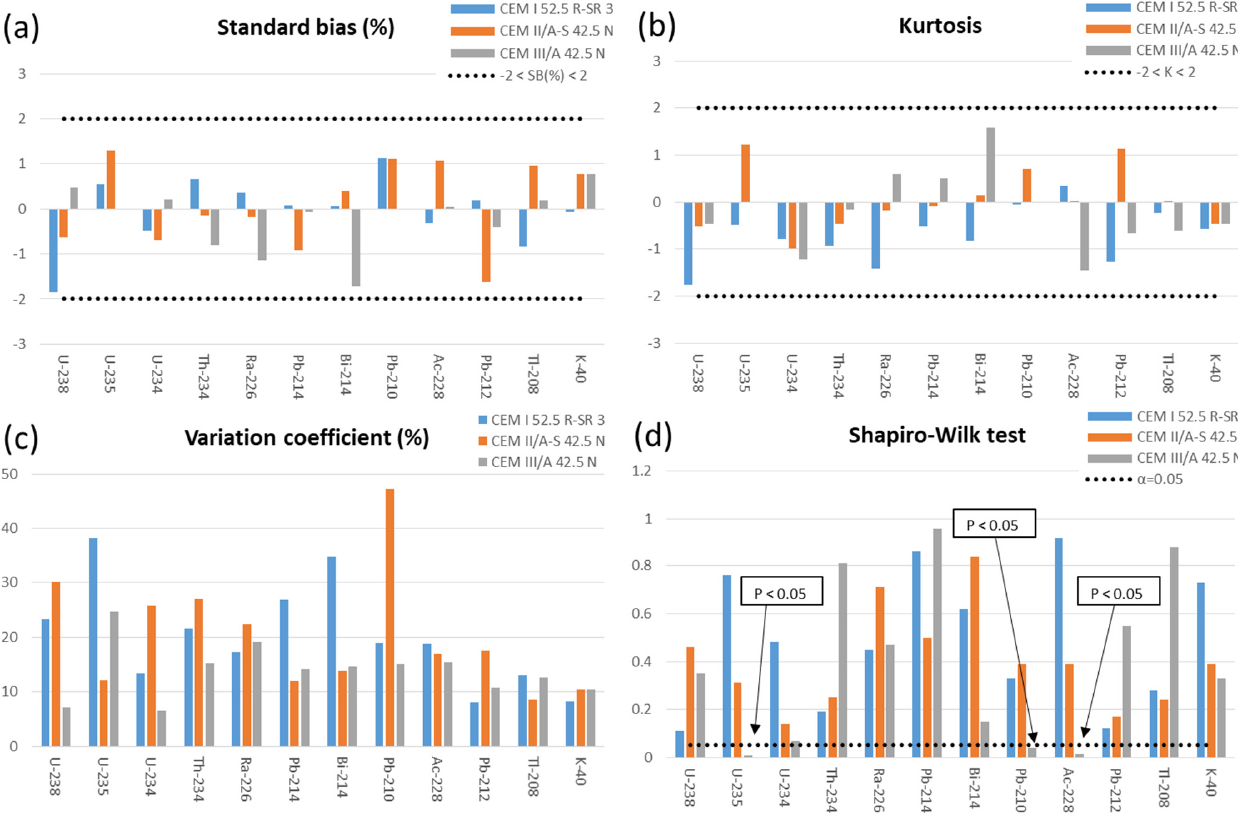
Figure 2. Statistical parameters obtained in the comparison of activity concentrations of carbonated and non-carbonated ground mortars: ( a ) SB standard bias (%), ( b ) K kurtosis, ( c ) variation coefficient (%), and ( d ) Shapiro–Wilk test statistic for normality.